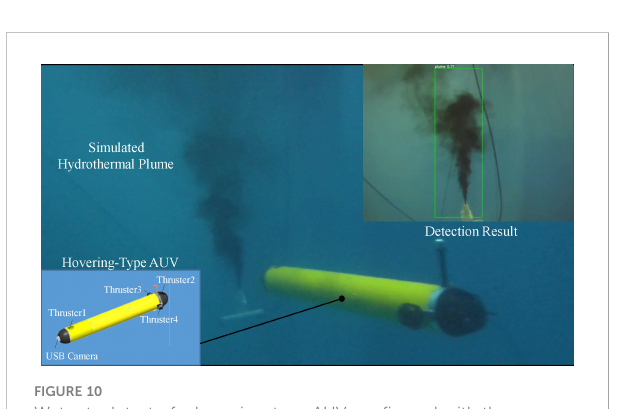
FIGURE 10 Water tank test of a hovering-type AUV con fi gured with the proposed plume detector.